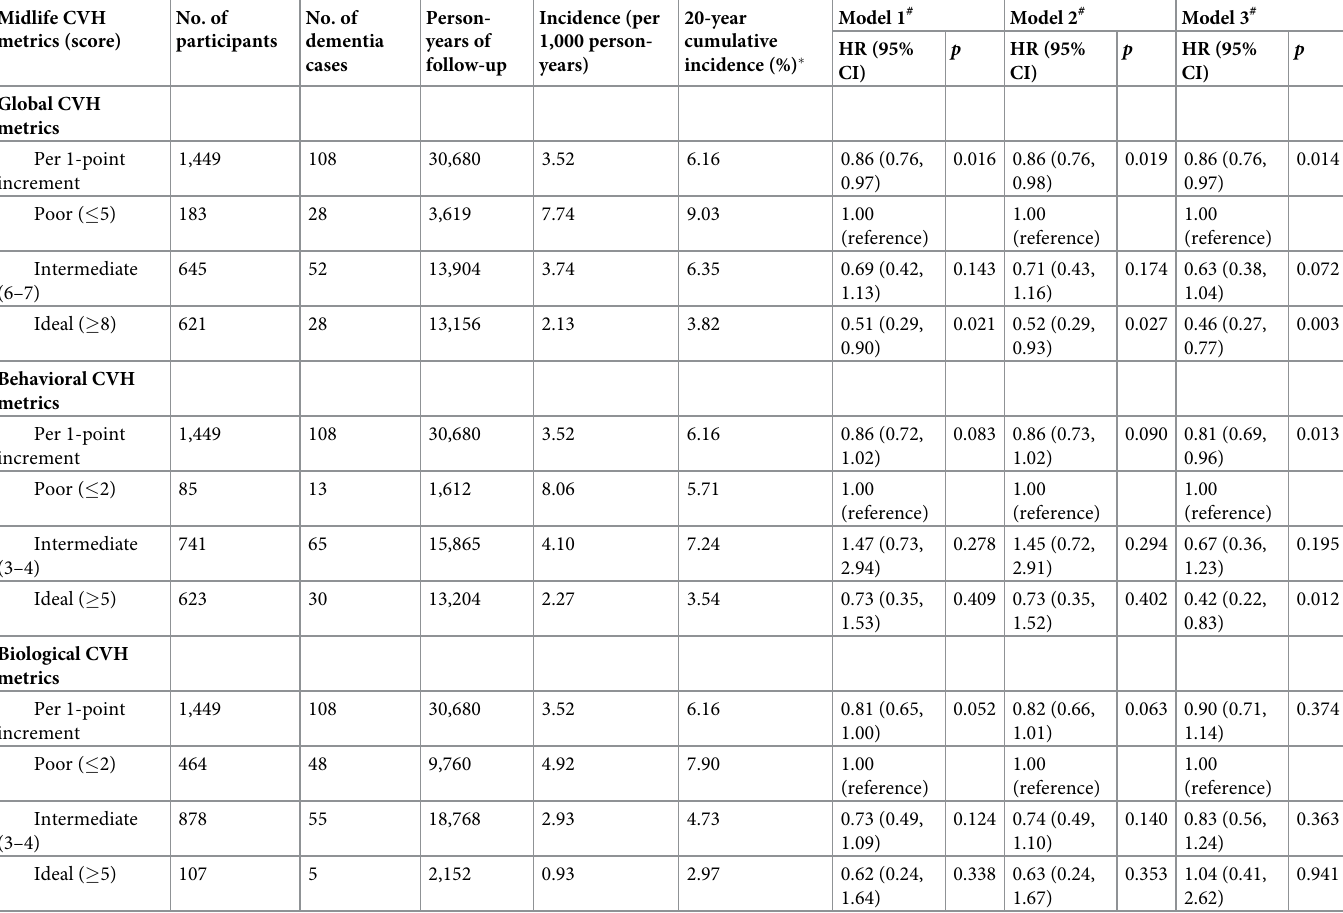
Table 3. The association of CVH metrics in midlife (1972 to 1987) and risk of dementia detected in late life (both 1998 and 2005 to 2008) ( n = 1,449). Midlife CVH metrics